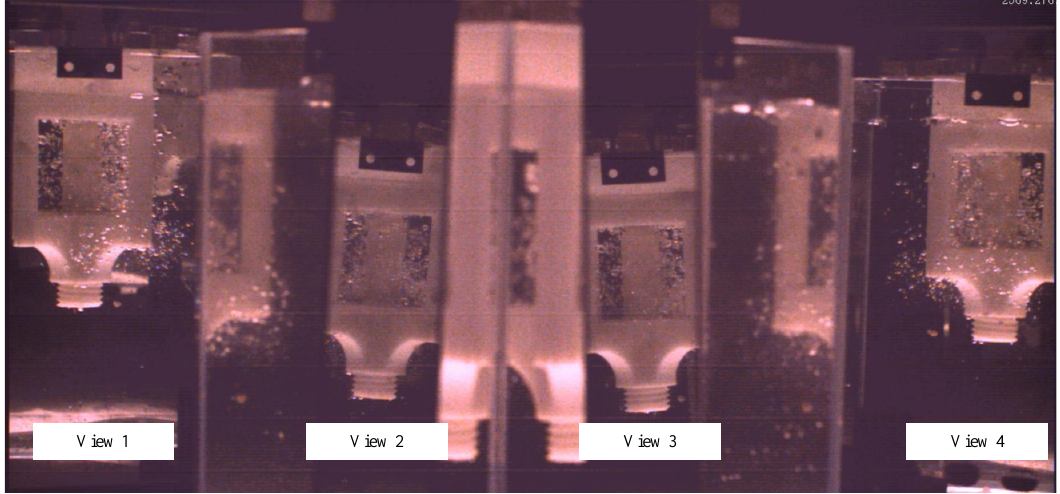
Figure 13. Experiment image examples from four